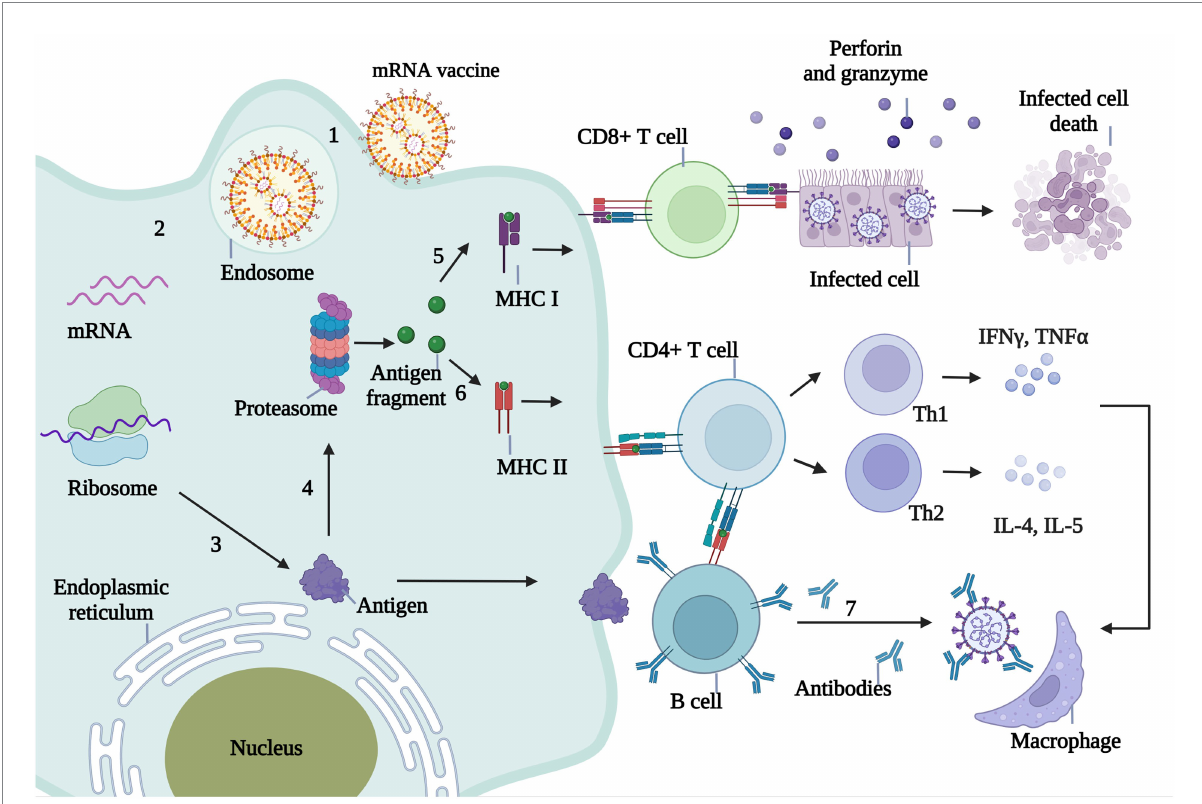
FIGURE 3 Immunological mechanism of mRNA vaccine against infectious diseases. 1. The mRNA wrapped by the delivery system enters the body and is ingested by antigen presenting cells (APC). 2. Endosomes release mRNA into the cytoplasm. 3. The mRNA in the cytoplasm is translated into the antigenic protein encoded by the ribosome. 4. Antigenic proteins in the cytoplasm are broken down into small antigenic fragments by proteasome complexes. 5. The decomposed antigen fragments were captured by MHC-I molecules and presented to CD8 + T cells. CD8 + T cells recognized the infected cells by MHC-I and released granuliase and perforin to lysate the infected cells. 6. Antigen fragments decomposed by proteasome complex can also be recognized by MHC-II molecules and presented to CD4 + T cells, which are divided into Th1 and Th2. Th1 cells secreted IFN γ , TNF α and Th2 cells secreted IL-4, IL-5 and other inflammatory factors to activate macrophages and eliminate viruses. 7.CD4 + T cells stimulate B cells to produce neutralizing antibodies, thus neutralizing invading